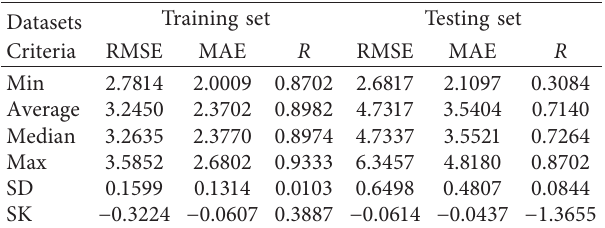
Table 4: Statistical analysis of prediction results over 200 RF simulations in terms of RMSE, MAE, and R .